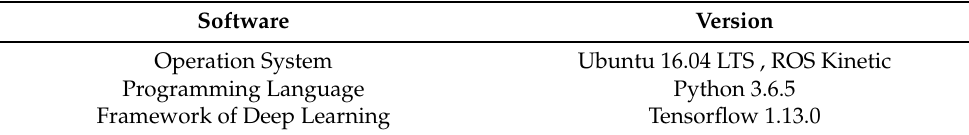
Figure 8. Turtlebot2 experimental platform. Table 3. Experimental software